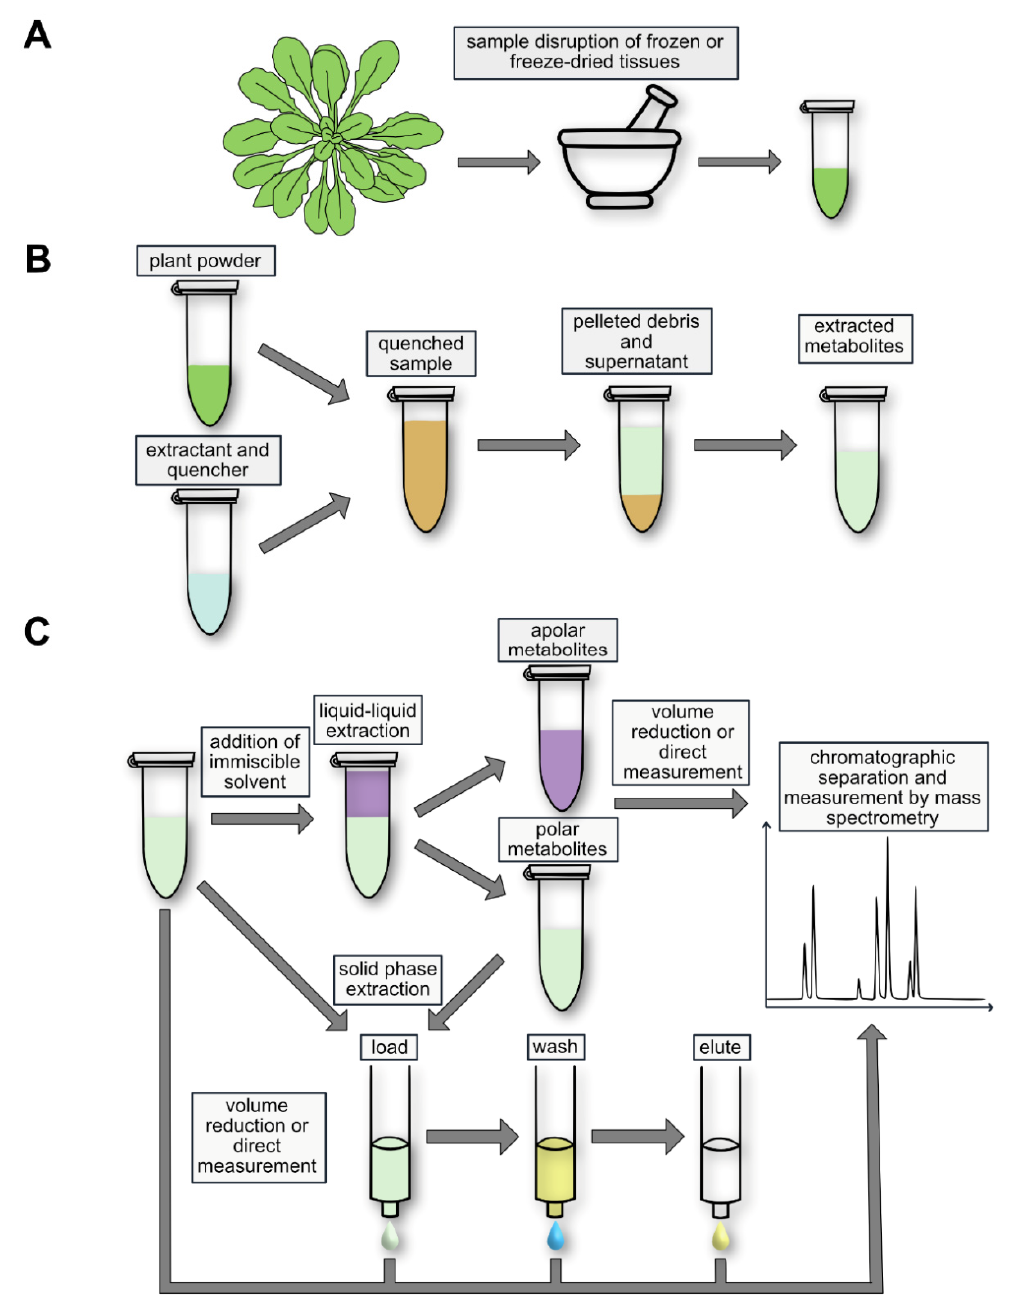
Figure 2. Schematic representation of a typical workflow for the analysis of nucleotides and nucleosides in plants. ( A ) Tissue disruption, here symbolized by mortar and pestle, is followed by ( B ) quenching of the sample and extraction of the metabolites. ( C ) Subsequently, non-polar and polar metabolites are separated by liquid–liquid extraction (LLE). The fraction containing polar metabolites can be further purified to enrich for nucleotides by solid-phase extraction (SPE) with a weak anion-exchange column. In this procedure, nucleotides are separated from nucleosides that are present in the flow-through. Extracts containing nucleosides and nucleotides can be separately analyzed using liquid chromatography and mass spectrometry.